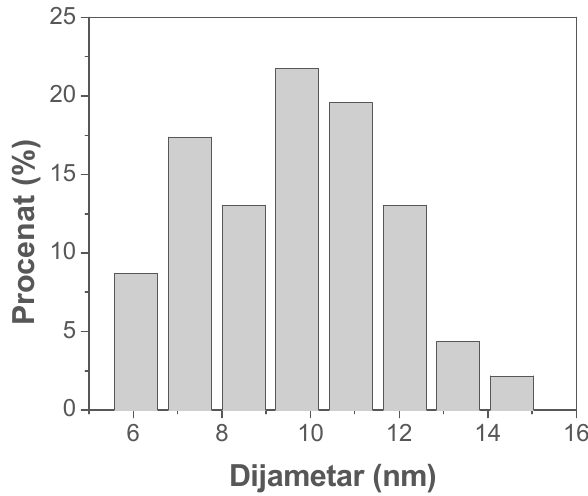
Figure 4 – Size distribution of α -Fe 2 O 3